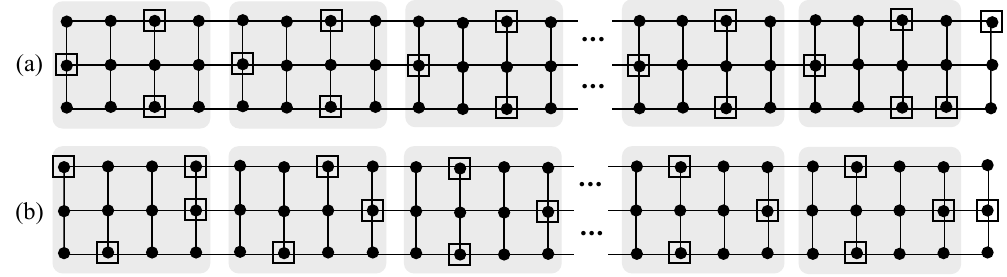
Figure 6: Eviction sets on the 3